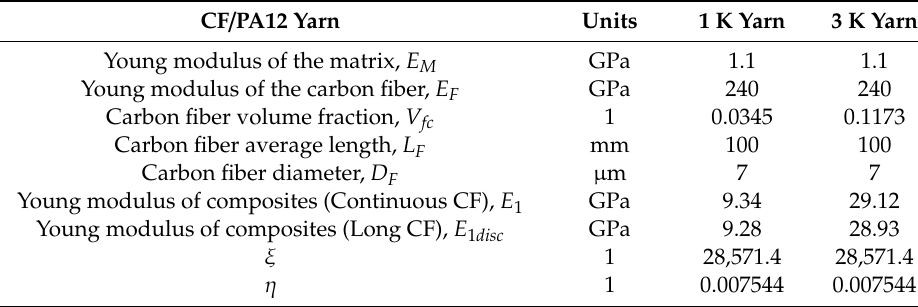
Table 5. Young’s modulus calculation results (c) the authors, CC BY-NC-ND 4.0 [17]. CF / PA12